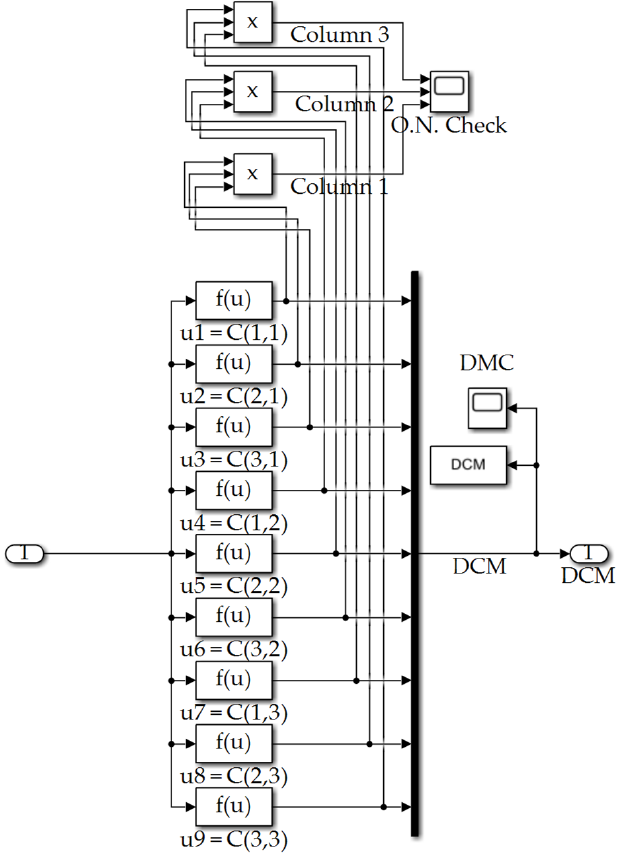
Figure A12. DCM subsystem depicted in Figure A1.